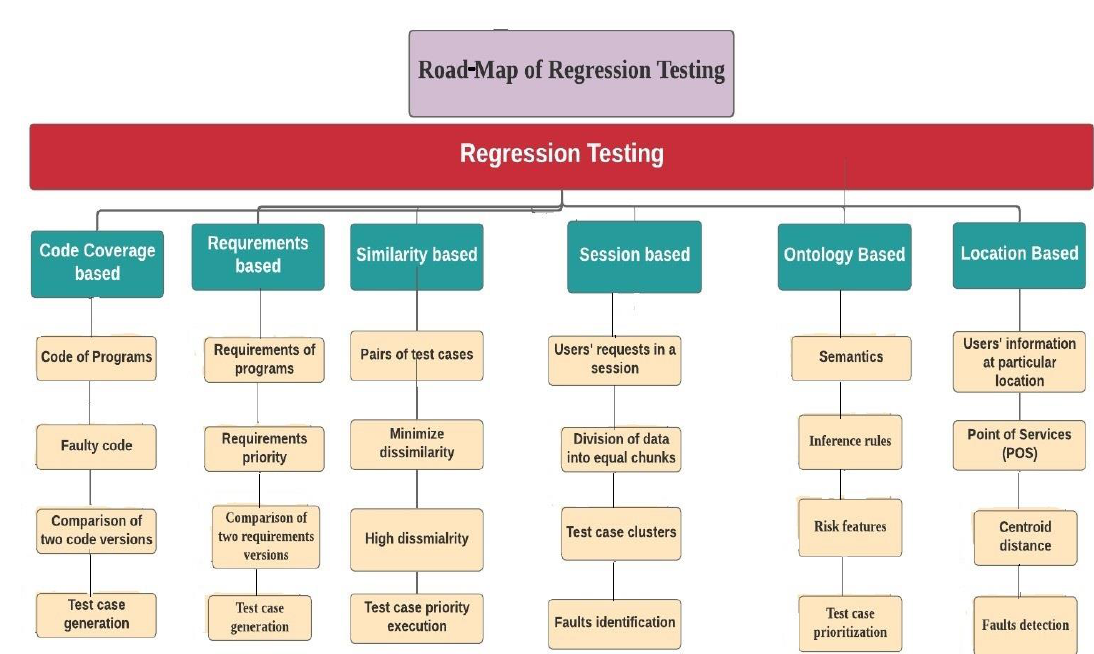
Figure 2. Roadmap of regression testing approaches.